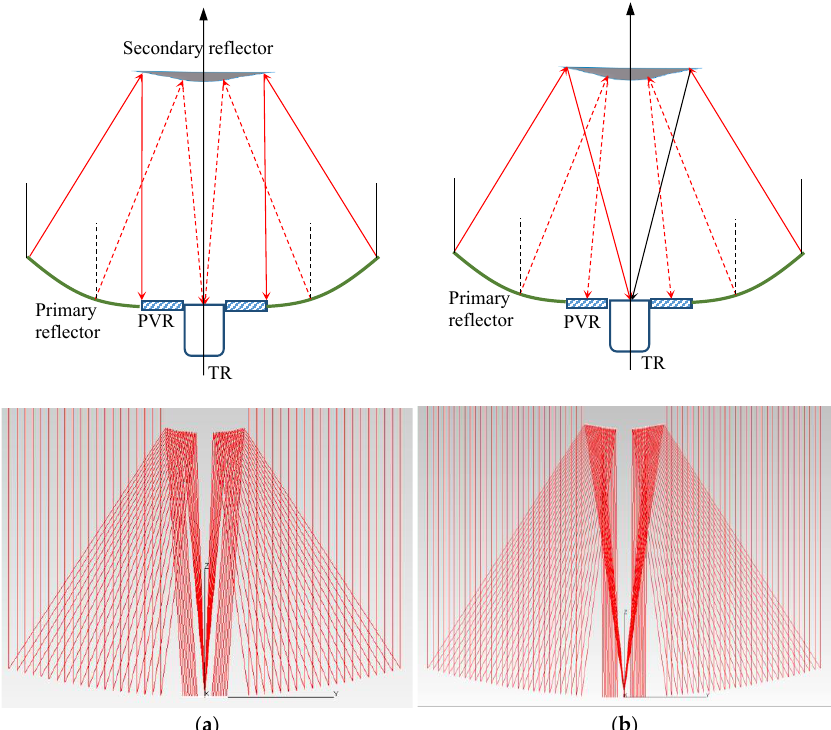
Table 1. Structural parameters of TFSC for ray-tracing simulations.